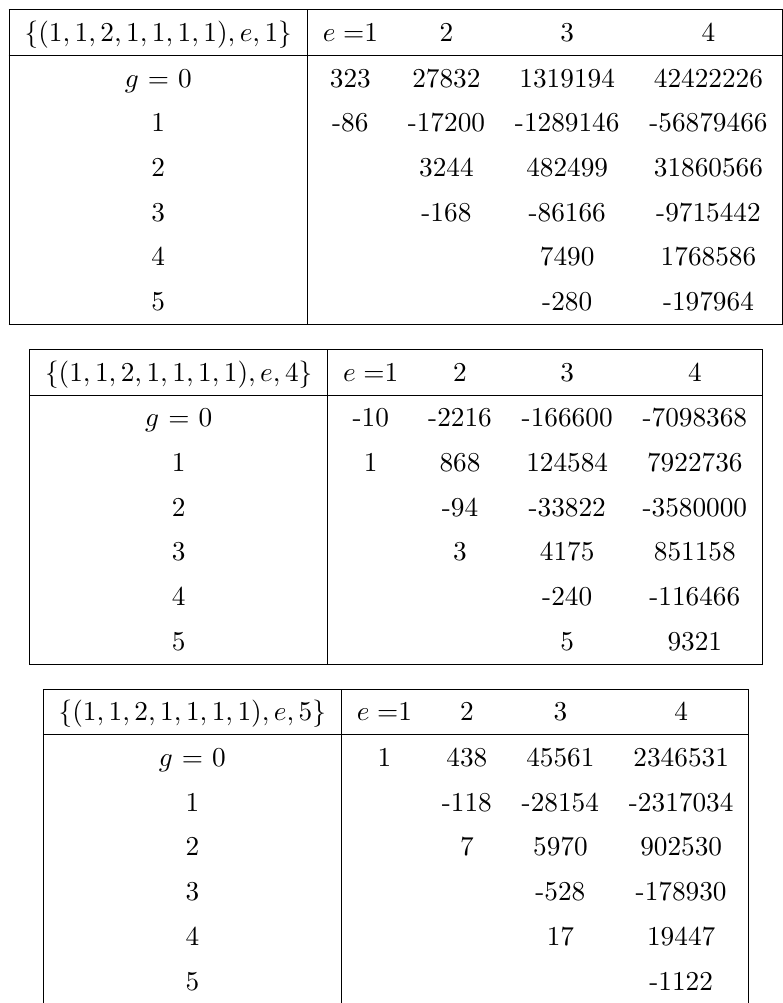
Table 10 . Refined GV invariants from (2,0) E 6 SCFT at base degree (1,1,2,1,1,1), fiber degree 1, 2 with mass degree 1 and 2 respectively.